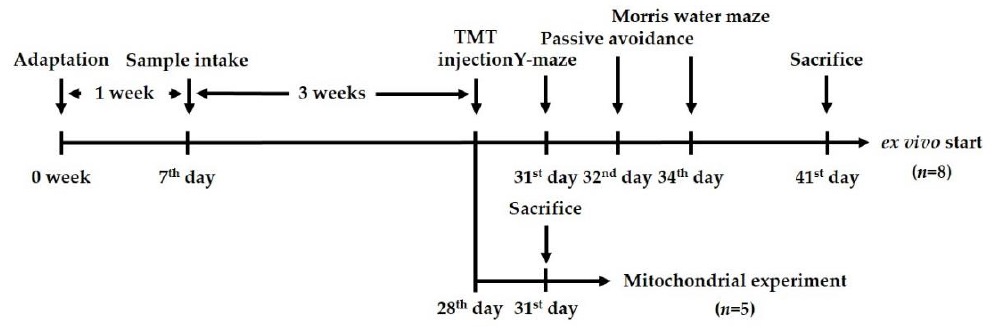
Figure 10. Experimental design of in vivo test for TMT (trimethyltin)-induced learning and memory impairment in